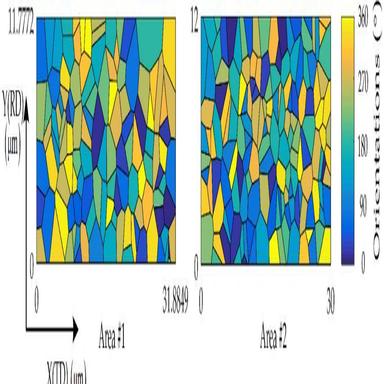
Selected voronoi areas for modeling.